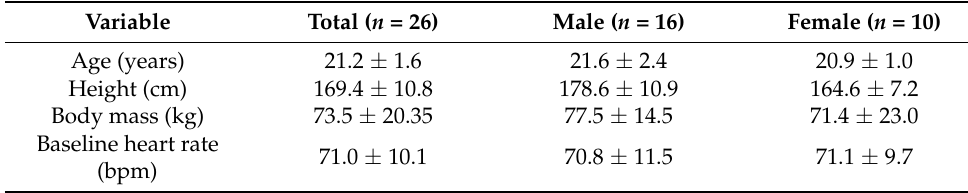
Table 1. Participant baseline